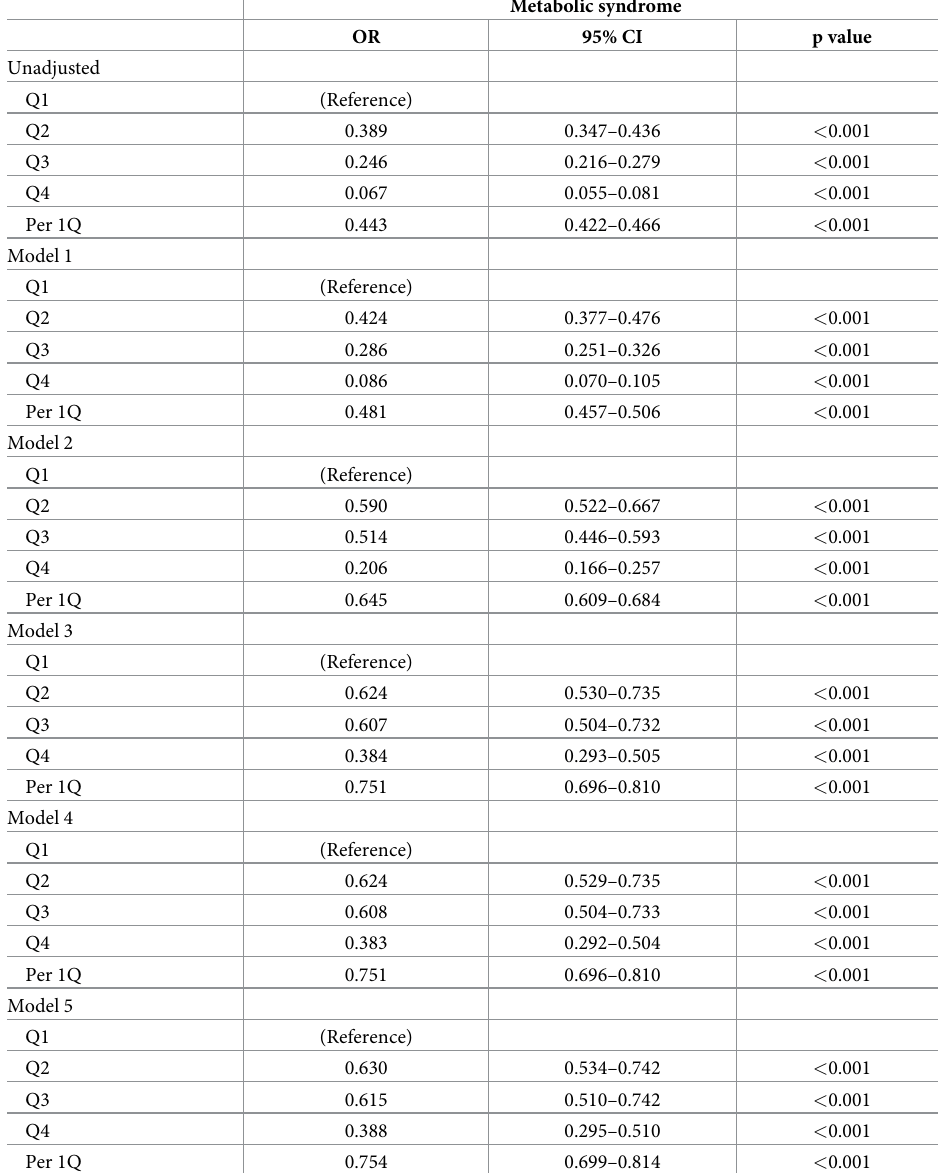
Table 5. Risk of metabolic syndrome in each quartile of